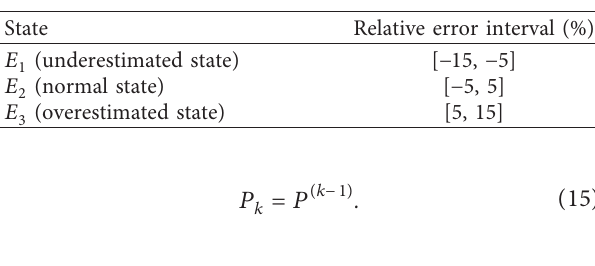
Table 3: State interval